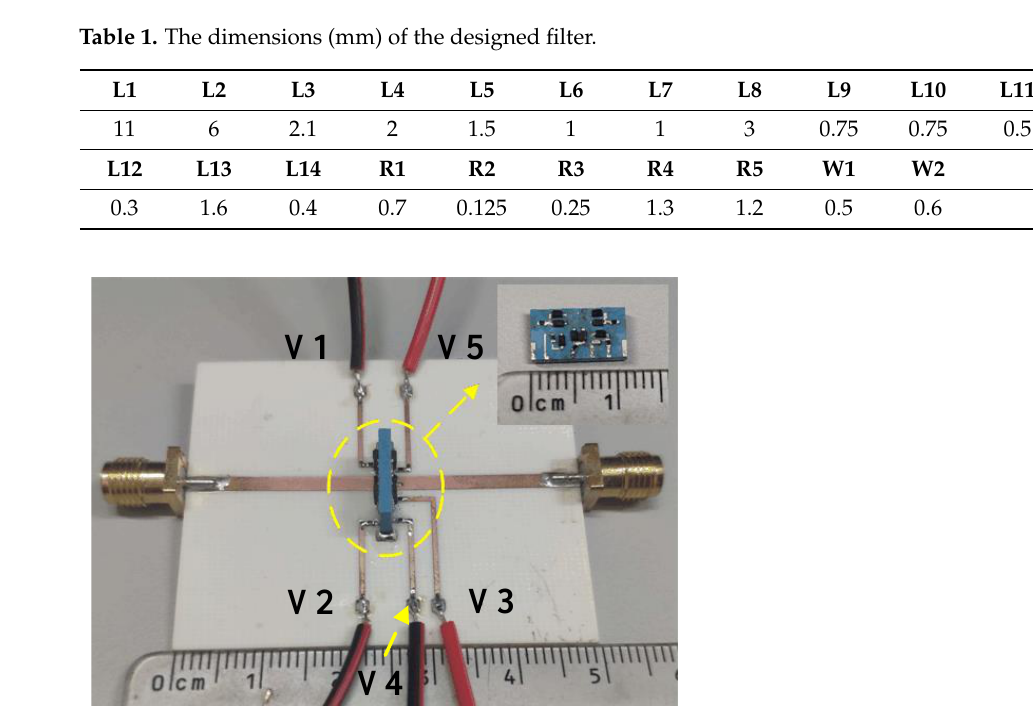
Figure 11. The photo of the proposed filter.